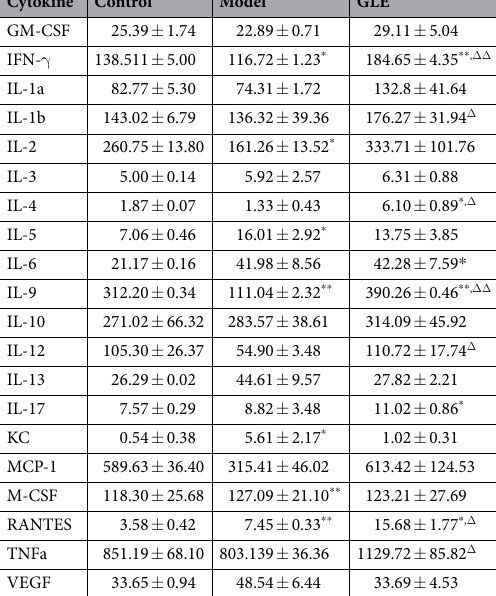
Table 4. The changes of serum cytokine concentration in mice after GLE treatment ( x ± s , n = 3). Note: Date in Table 4 was based on Log-Log Regression Standard Curves. * P < 0.05; ** P < 0.01, versus control values; Δ P < 0.05; ΔΔ P < 0.01, versus model